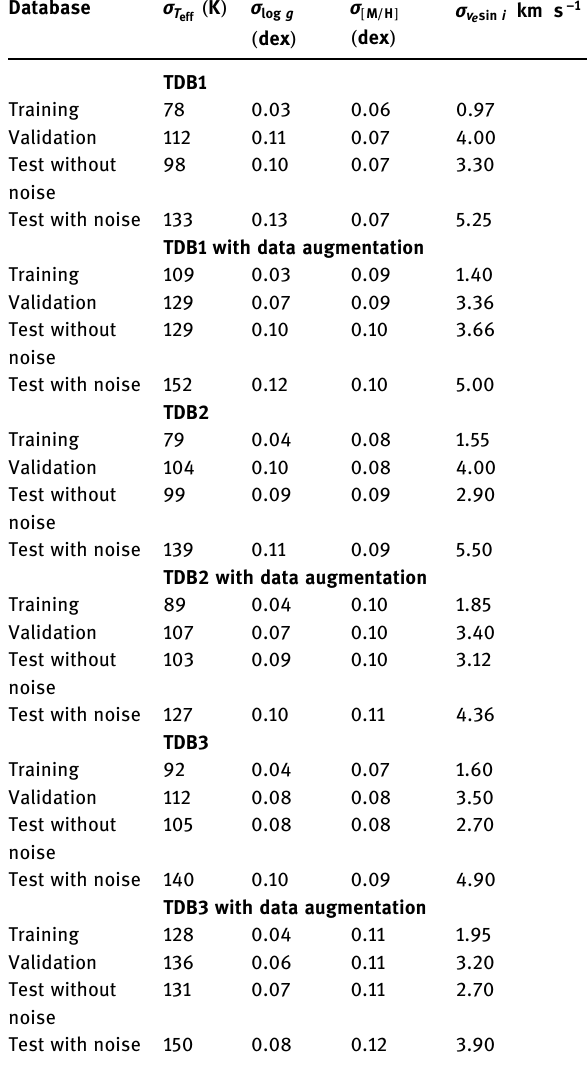
Figure 9: Relative errors for each stellar parameter using TDB1, TDB2, and TDB3 with and without data augmentation as a training dataset.